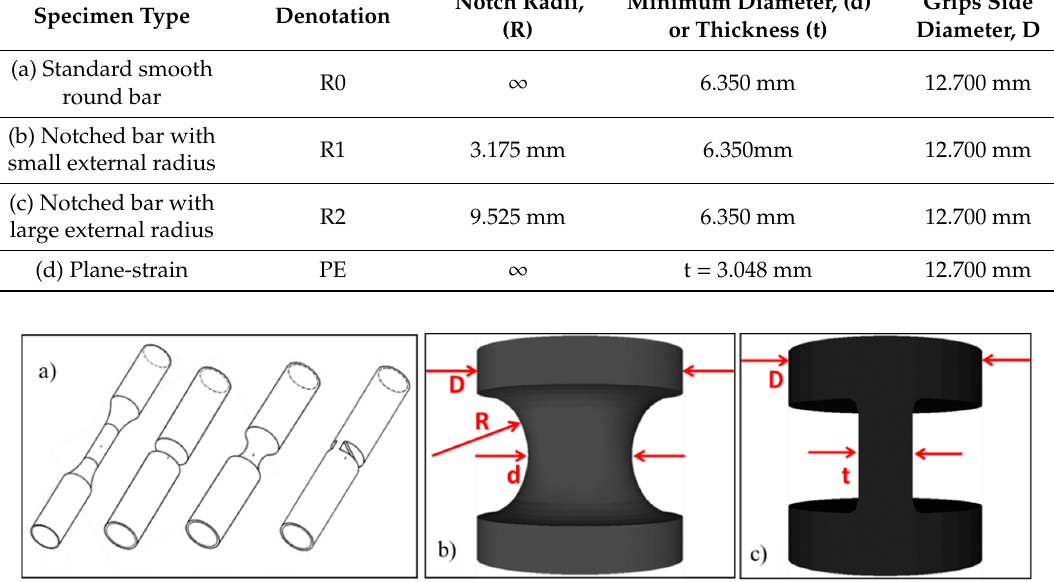
Table 7. Key dimensions and denotation of the four samples.